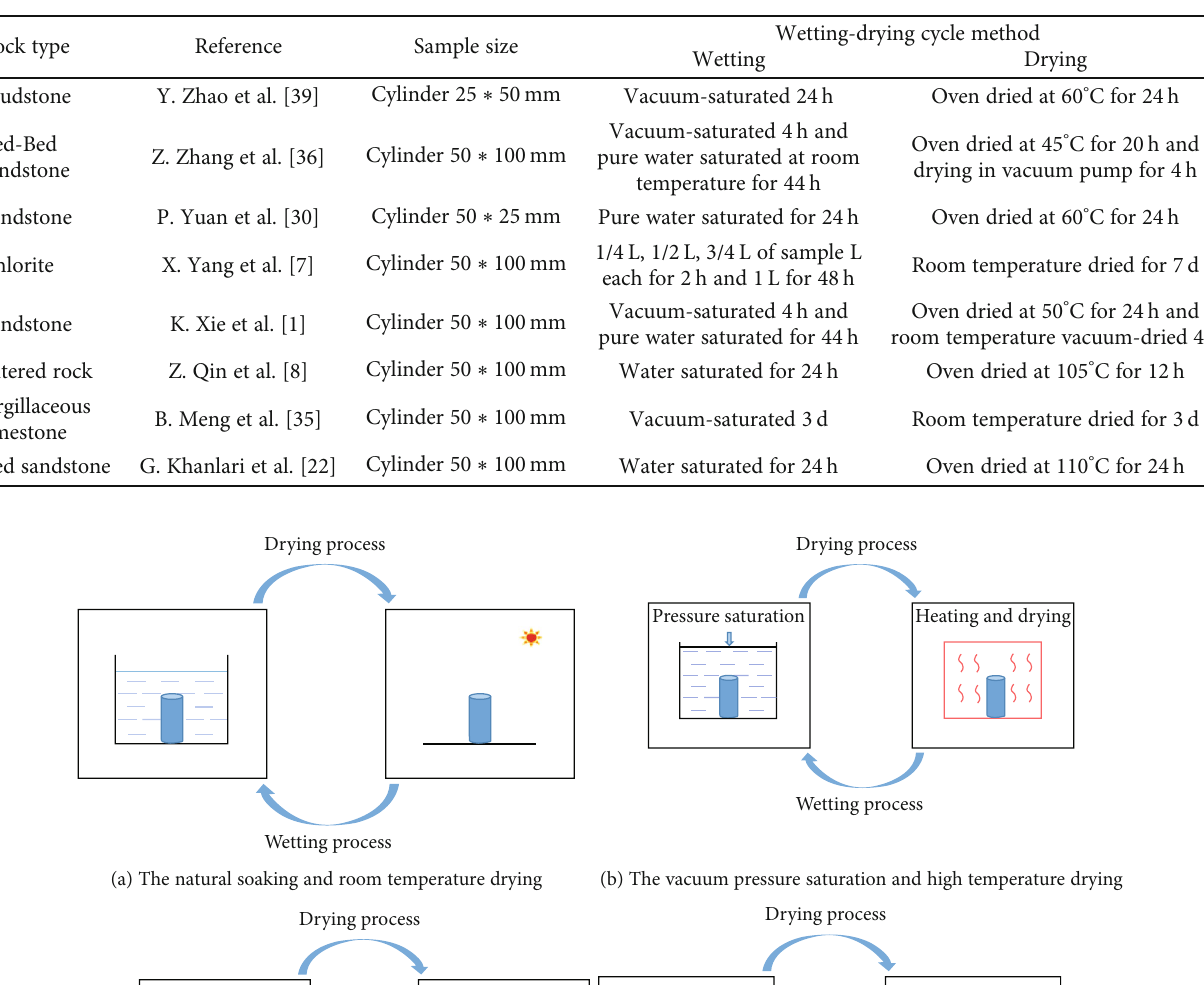
Table 1: Di ff erent cyclic dry-wet treatment methods.